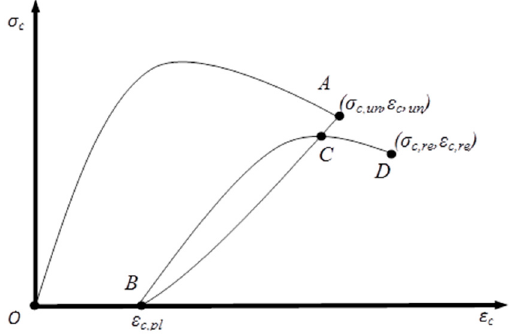
Figure 1. Typical stress–strain curve of masonry under cyclic compression.